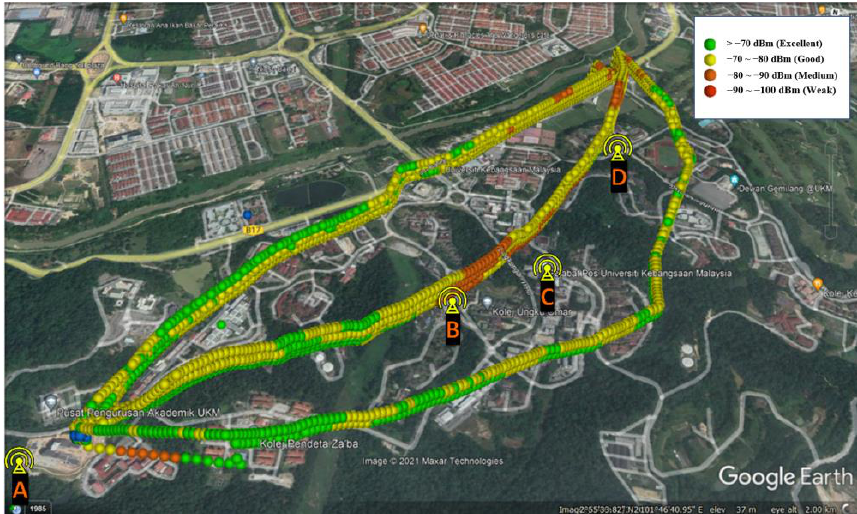
Figure 5. Measured RSRP values at different routes and elevations.